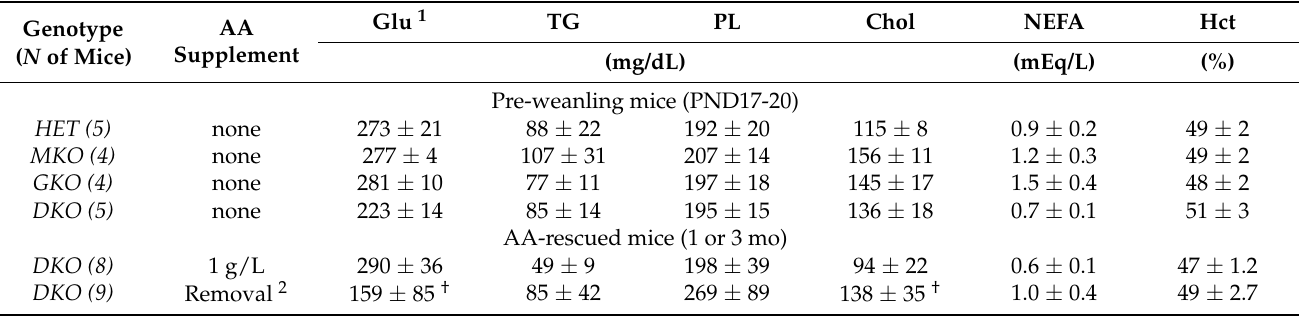
Table 1. Plasma metabolites profile and